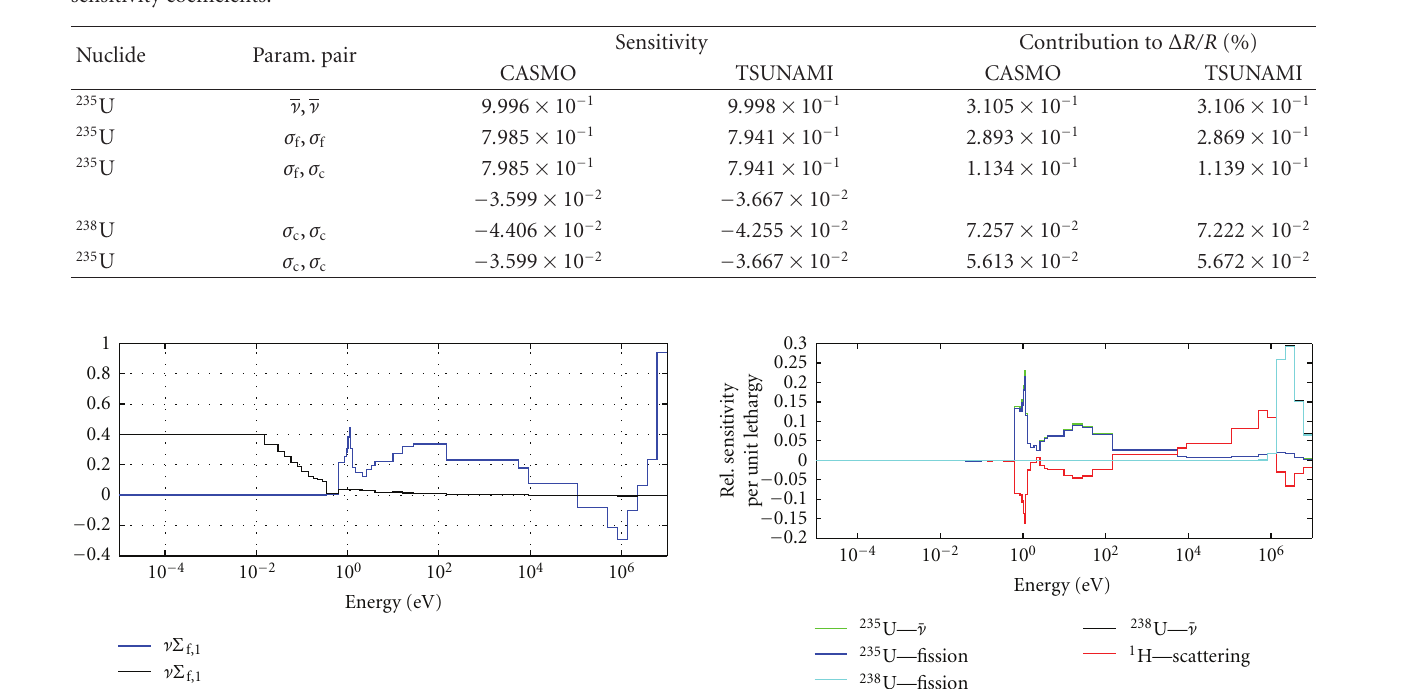
Table 5: The five most significant sources of uncertainty for the response ν Σ f,2 and the corresponding energy- and region-integrated relative sensitivity coe ffi cients.